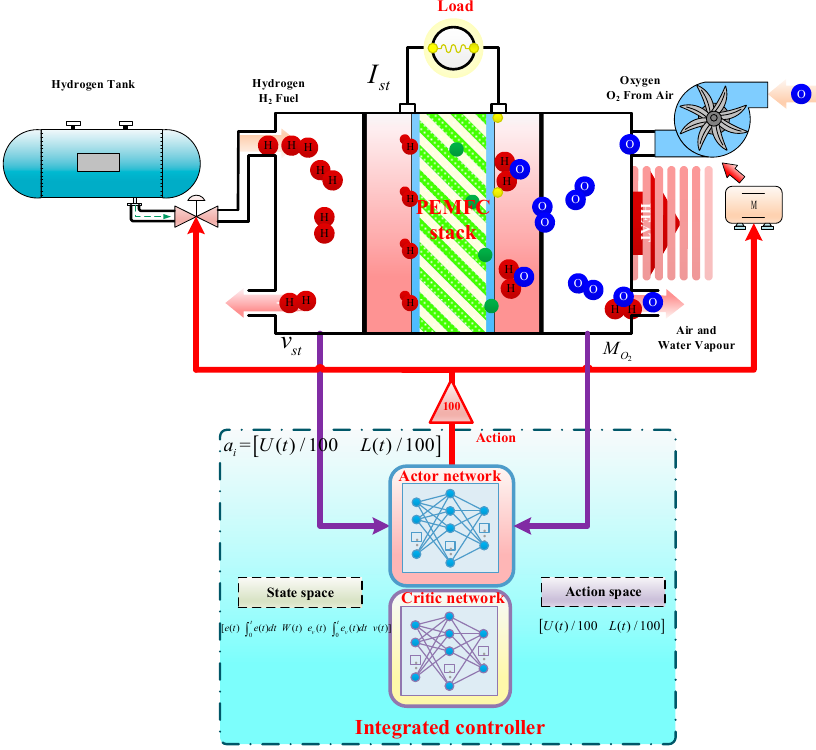
Figure 5. Integrated control of PEMFC gas supply system based on ECMTD-DDPG algorithm.